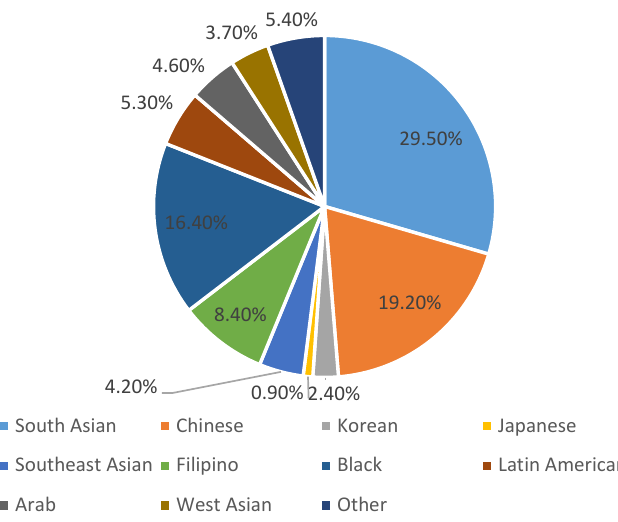
Figure 1. Visible Minorities in Ontario.